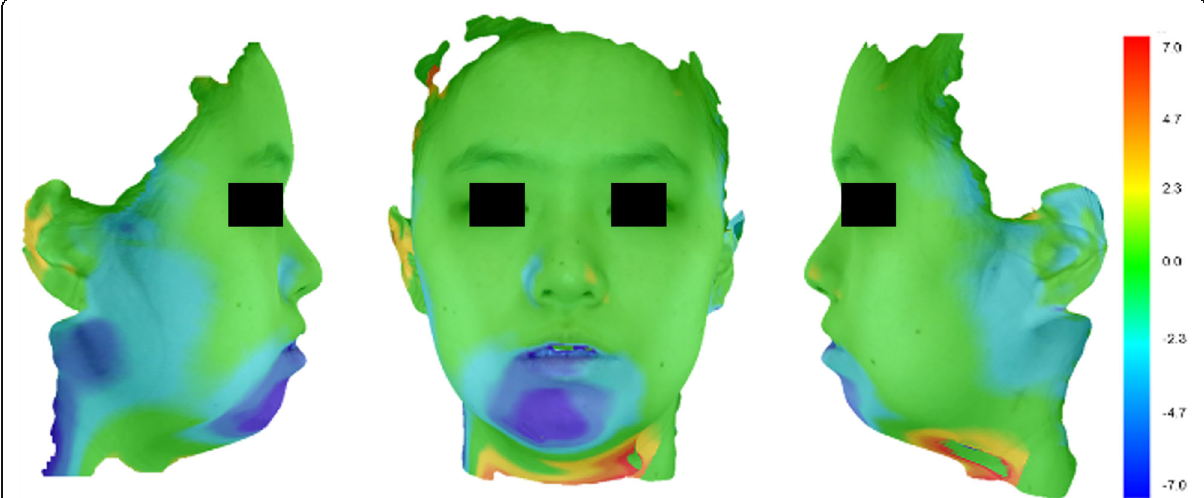
Fig. 5 Superimposed color map image using concentration gradient of colors, before and after mandibular setback surgery. Increases in blue color gradient indicate greater inward displacement after MSS. Green color indicates no change. The greatest change occurred in the chin area with an increasing gradient from the lower lip to chin and from side to midline